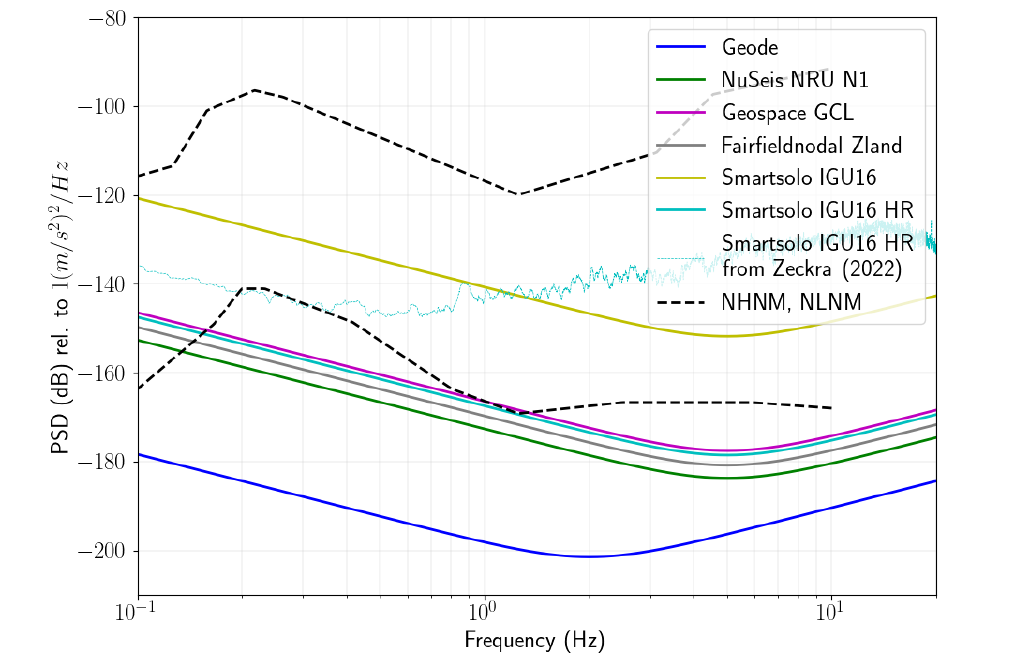
Figure 3. Theoretical self-noise for popular nodal geophones compared to the Geode and the measured self-noise from